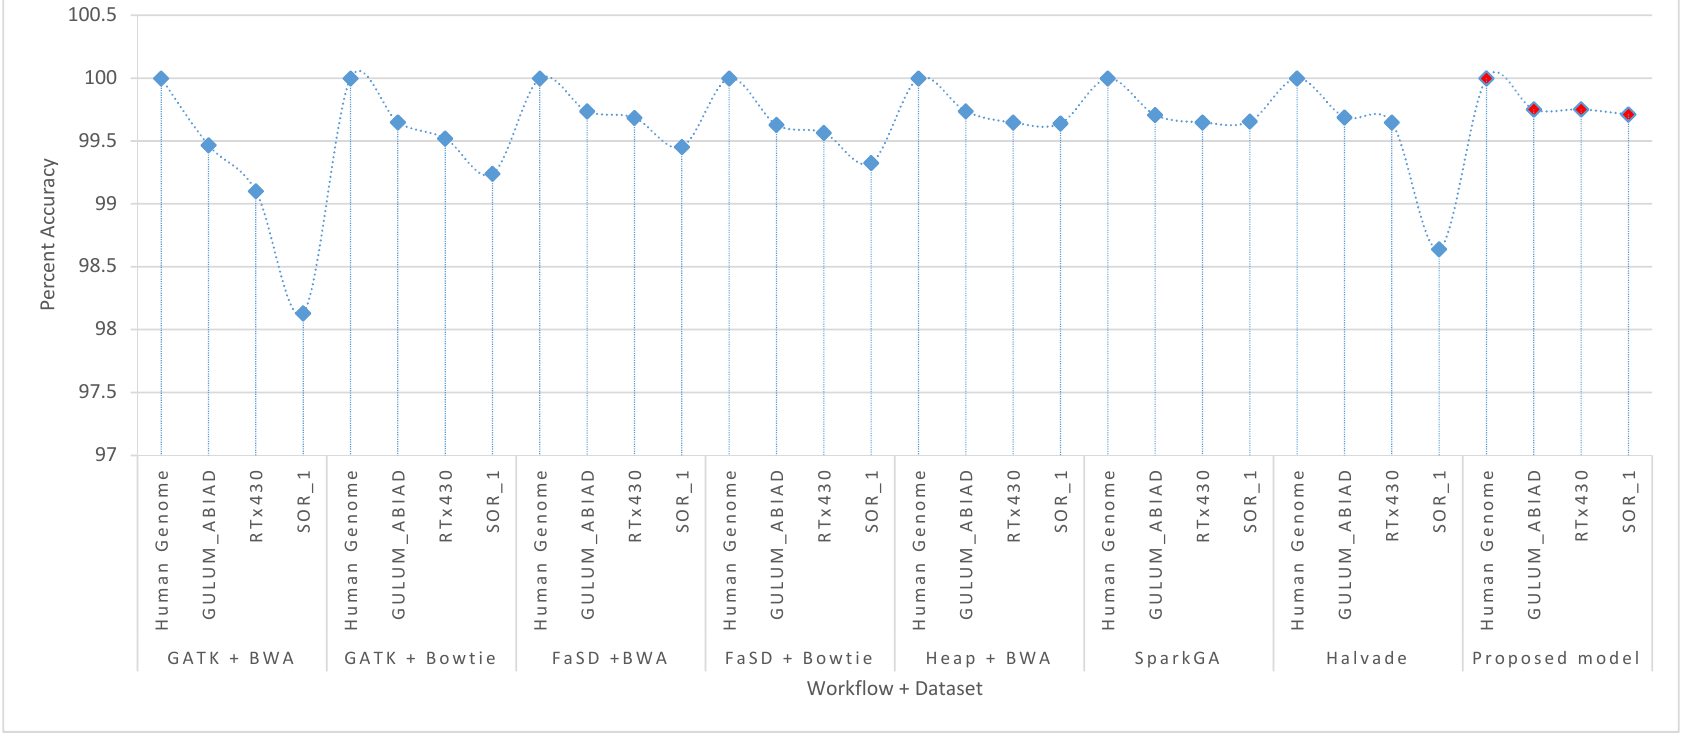
Figure 4. Comparative results analysis of proposed and existing workflows in terms of percent accuracy measurement on the Human genome, GULUM_ABIAD, RTx430, and SOR_1 datasets. The figure shows the results for GATK + BWA, GATK + Bowtie, FaSD + BWA, FaSD + Bowtie, Heap + BWA, SparkGA, Halvade and proposed workflows respectively. The diamond shape marker over the dotted line shows the discrete points for the accuracy of the respective workflow and dataset. The light blue marker shows the existing workflows, while the solid red filled marker shows the points for the proposed workflow. Results analysis of graphs shows that the proposed workflow comparatively outperforms than existing workflows.